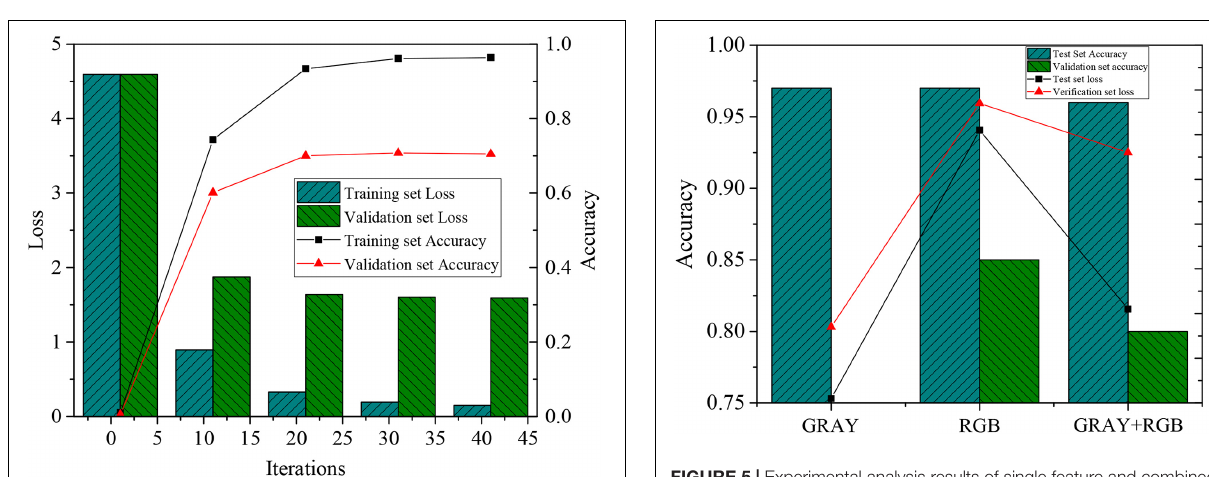
FIGURE 5 | Experimental analysis results of single feature and combined features.